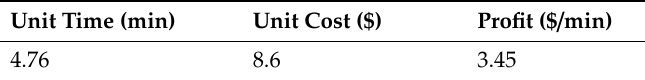
Table 11. Unit cost, time, and profit.